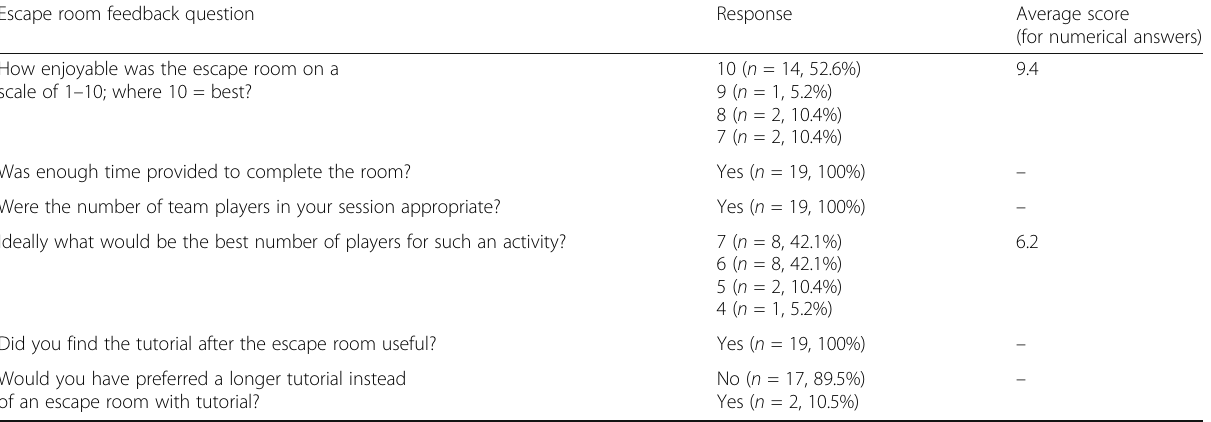
Table 1 Participant feedback on escape room enjoyment, set-up and difficulty of puzzles Escape room feedback